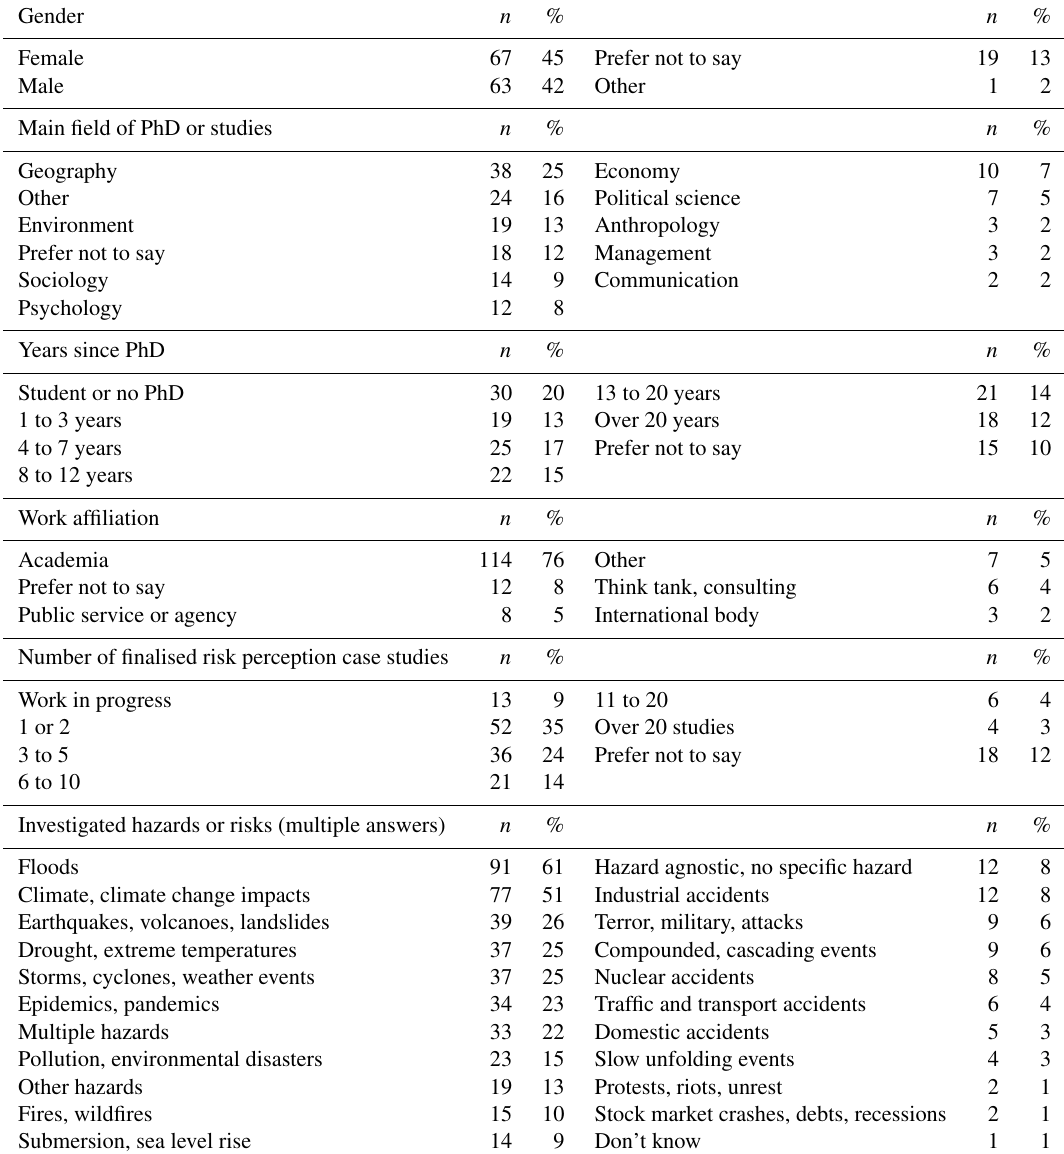
Table 1. Participants’ characteristics and hazards they